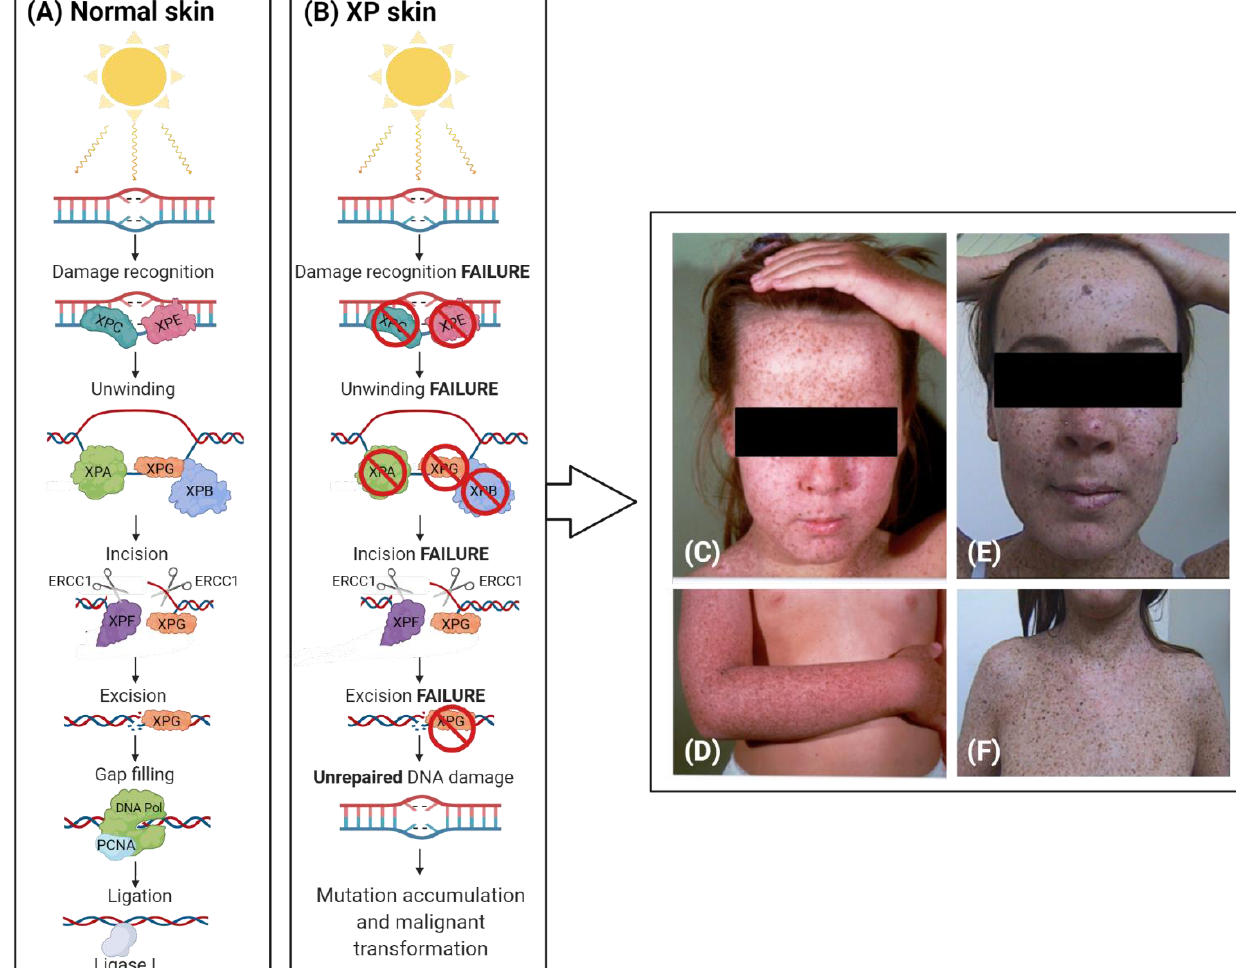
Figure 1. Schematic representation of DNA repair machinery in normal ( A ) and XP ( B ) skin. ( C – F ) Some clinical features of UV-induced damage in XP patients are reported. (Created with BioRender . com).